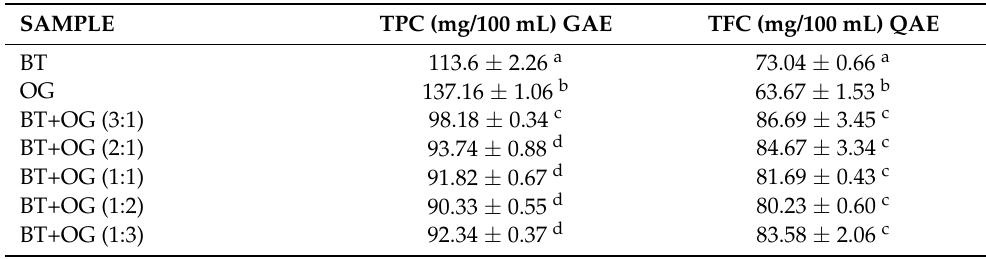
Table 2. The total phenolic content (TPC)/total flavonoid content (TFC) of black tea and O. gratissimum , alone or in a binary mixture at five different